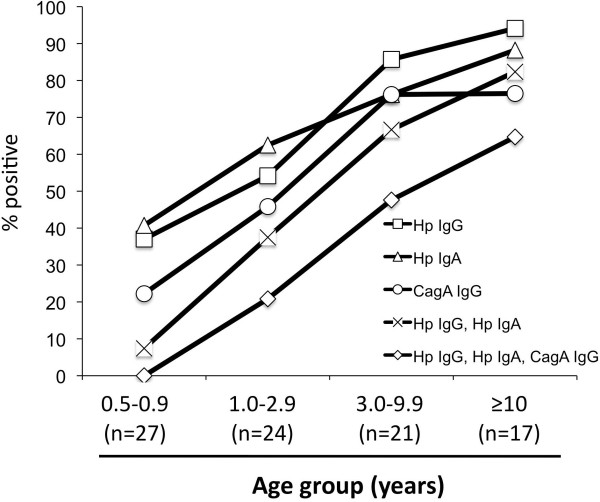
H. pylori IgG, IgA, and CagA status of 89 healthy Rhesus macaques by age. Rates of positivity for H. pylori colonization and CagA-status, according to five different serological classifications defining positivity.